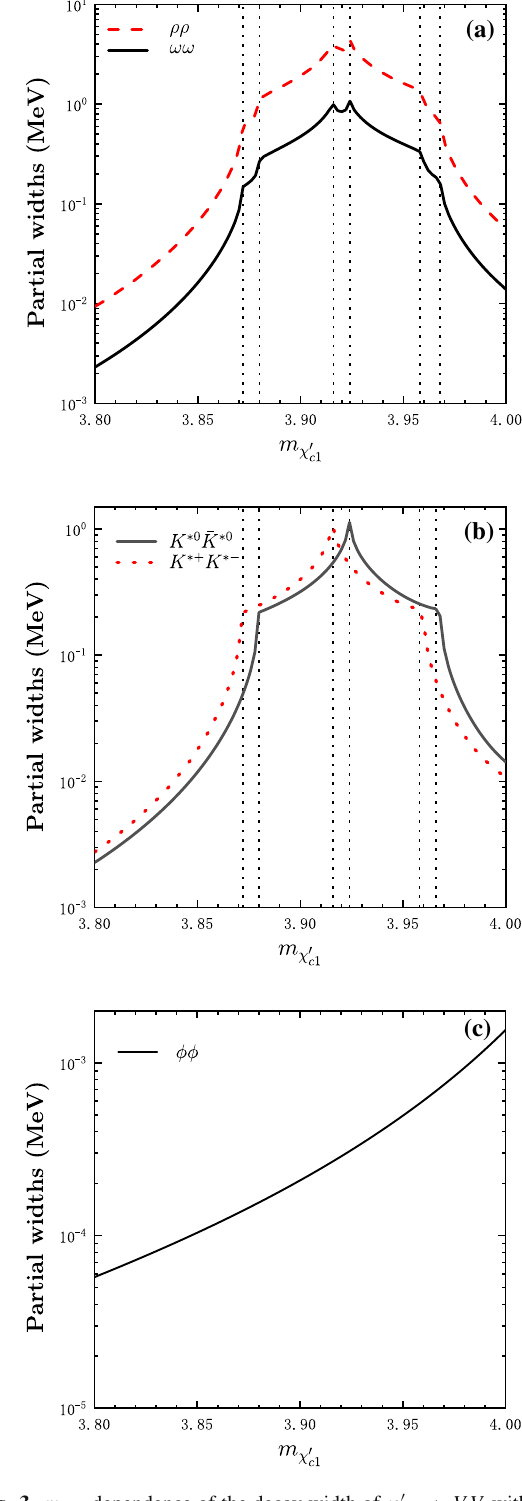
Fig. 3 m χ (cid:2) -dependence of the decay width of χ (cid:2) c 1 0 .